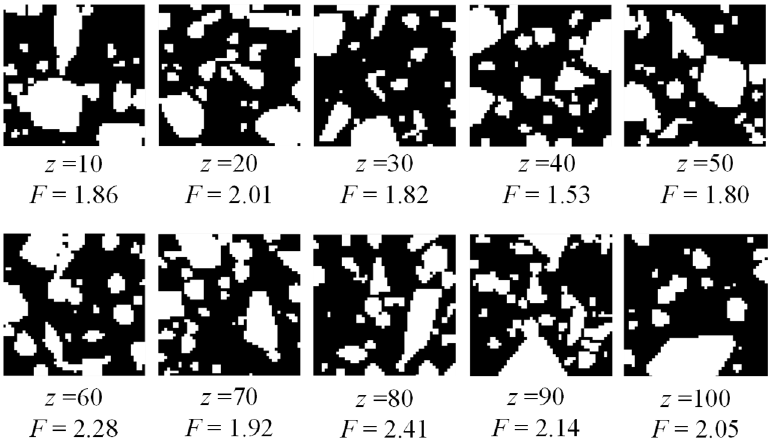
Figure 7. Cross-sections of the generated SRM mesostructure in different depths and their fractal dimension.